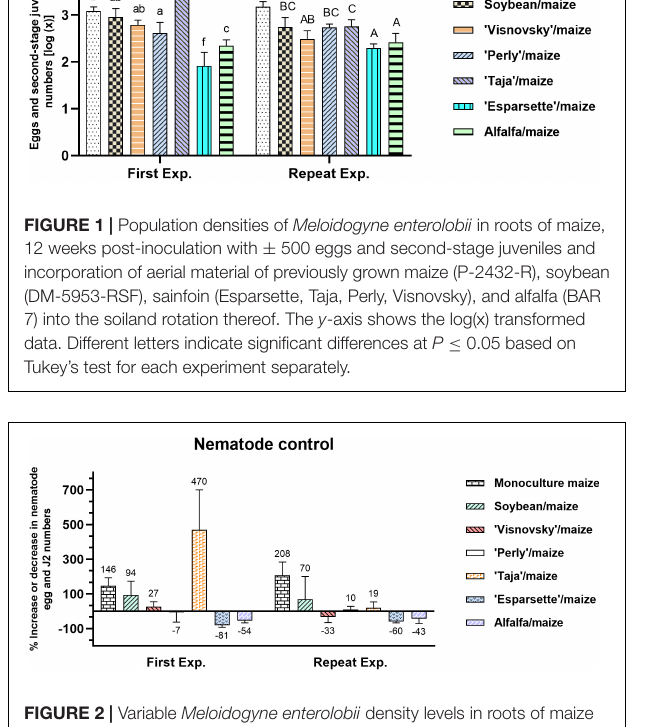
FIGURE 4 | Plant height (cm) of maize plants, 12 weeks post-inoculation with ± 500 eggs and second-stage juveniles of Meloidogyne enterolobii , and incorporation of aerial material of maize (P-2432-R), soybean (DM-5953-RSF), sainfoin (Esparsette, Taja, Perly, Visnovsky), and alfalfa (BAR 7) into the soil and rotation thereof. The y -axis shows plant height value (cm). Different letters indicate significant differences at P ≤ 0.05 based on Tukey’s test for each experiment